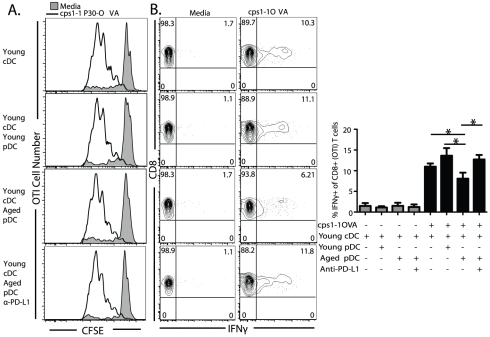
PD-L1 mediated suppression of effector function not expansion of antigen specific T cells by aged mouse pDC.Sorted young cDC with or without young or aged mouse pDC were stimulated with RHΔcps1-1P30-OVA transgenic tachyzoites for 12 hours in presence or absence of anti-PD-L1 (30 µg/ml). For proliferation, 2×104 CFSE labeled CD8+ OTI T cells and 5×105 CD45.1 TCRb purified T cells were added to the cultures and 72 hours later OTI cells were analyzed for (A) CFSE dilution shown by histogram. To assess effector function, 2×103 CD8+ OTI T cells and 5×105 CD45.1 TCRb purified T cells were added to the cultures and after 3 days restimulated with freshly isolated CD45.1 splenocytes and 1 µg/ml SIINFEKL peptide for 5 hours then intracellularly stained for IFNG. (B) Contour plots show OTI IFNg production and frequencies. (B) Bar graph shows mean ± SD of percent of IFNg+ OTI T cells. * denotes significance with p<0.05 by 1 way ANOVA and Bonferroni's multiple comparison test. Data is representative of one experiment repeated independently twice in quadruplicate.